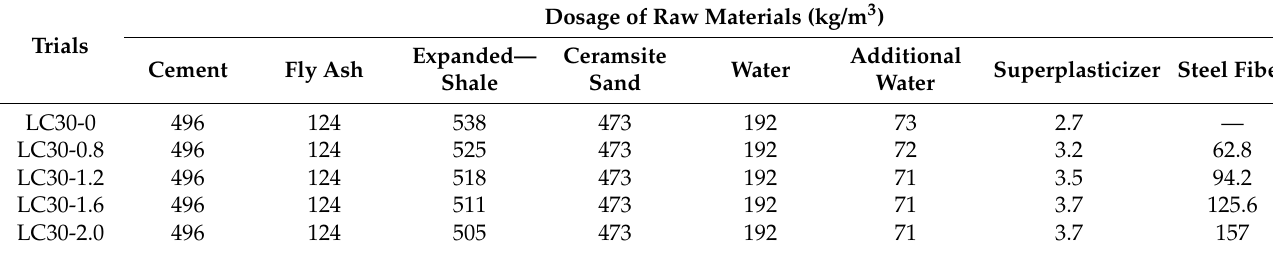
Table 5. Mix proportion of high-performance SFRELC.